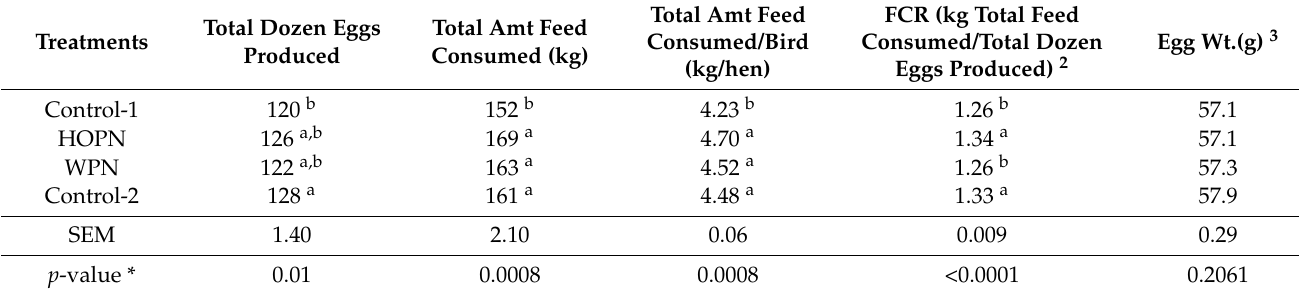
Table 4. Production performance per replicate of hens fed a control or peanut-containing diet 1